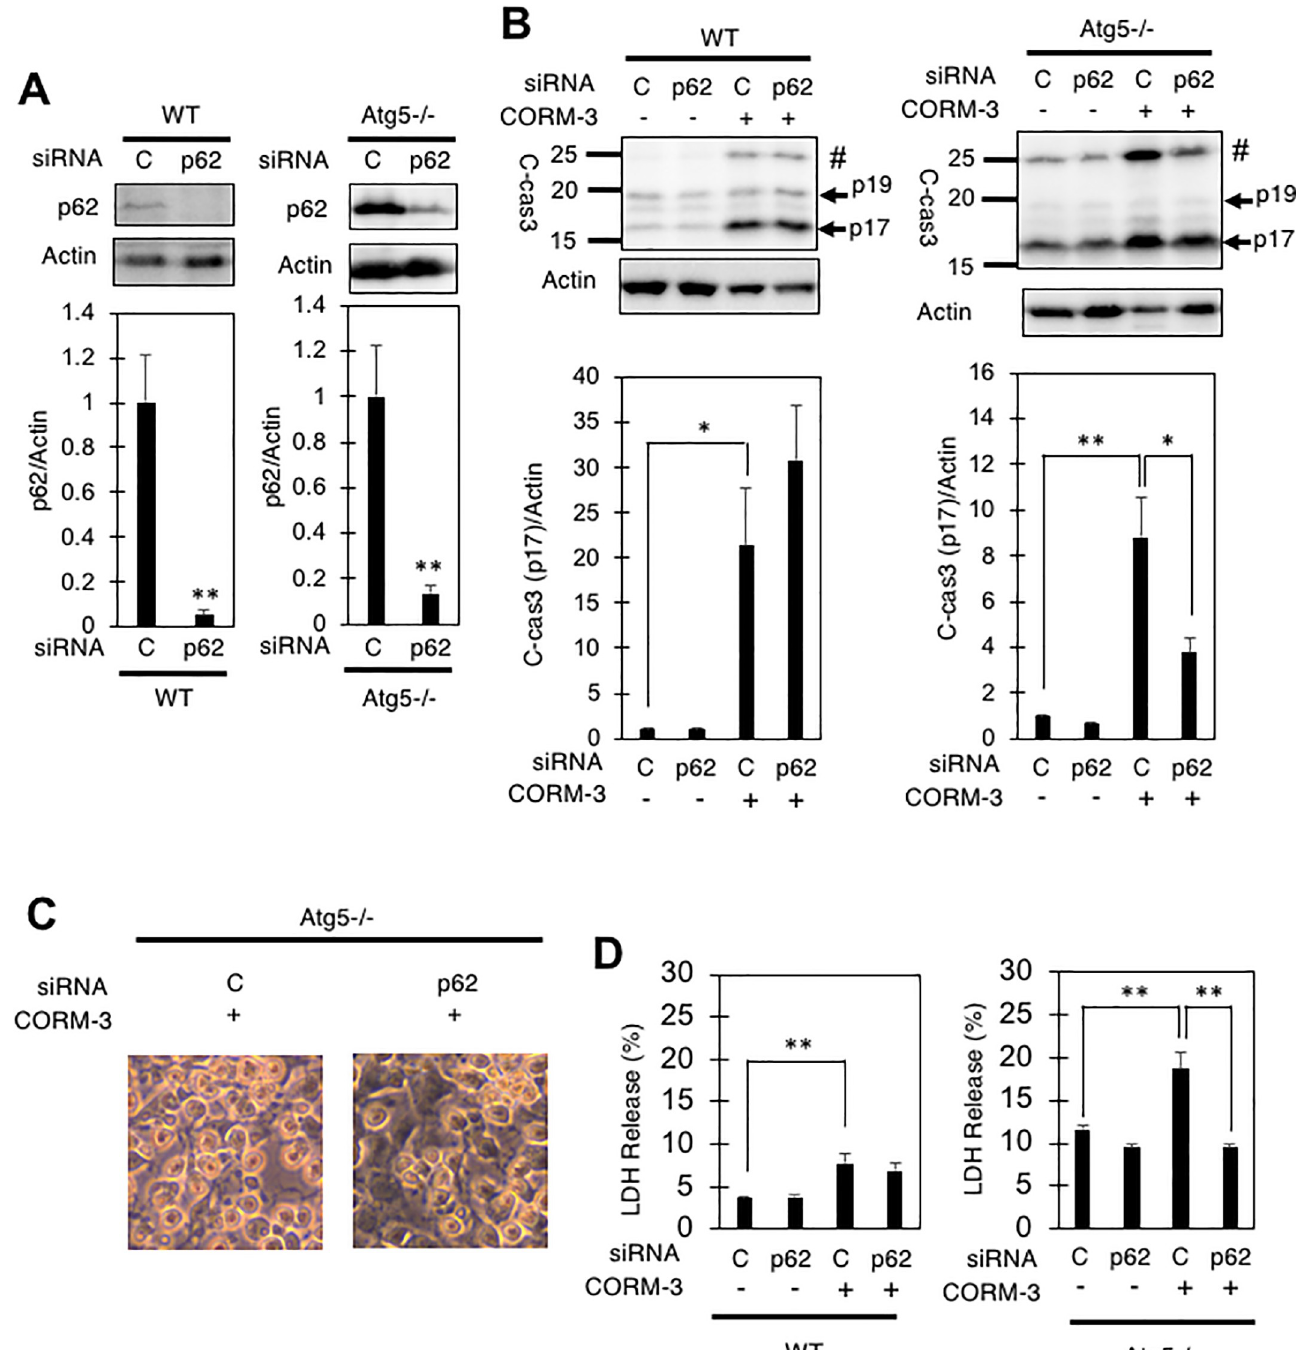
Fig 7. Effects of siRNA-mediated knock-down of p62 on CORM-3-induced death of atg5-/- MEFs. (A) WT and atg5-/- MEFs were treated with a control siRNA (C) or a siRNA for p62 (p62) and examined for their intracellular levels of p62 (left panels) by immunoblotting. #, uncharacterized fragment. The graphs show the means and S.E. of four samples. �� , p < 0.01 by student’s t -test. (B) SiRNA-treated MEFs were also exposed to 1 mM CORM-3 for 48 hours, and the relative levels of p17 fragment of cleaved-caspase-3 (c-cas3) were determined by immunoblotting. The graphs show the means and S.E. of four samples. � , p < 0.05; �� , p < 0.01 by Turkey-Kramer’s test. Representative images of atg5-/- MEFs treated with or without the siRNA for p62 and then incubated with 1 mM CORM-3 for 48 hours, are shown (C). Percentages of LDH into the medium is also shown (D).